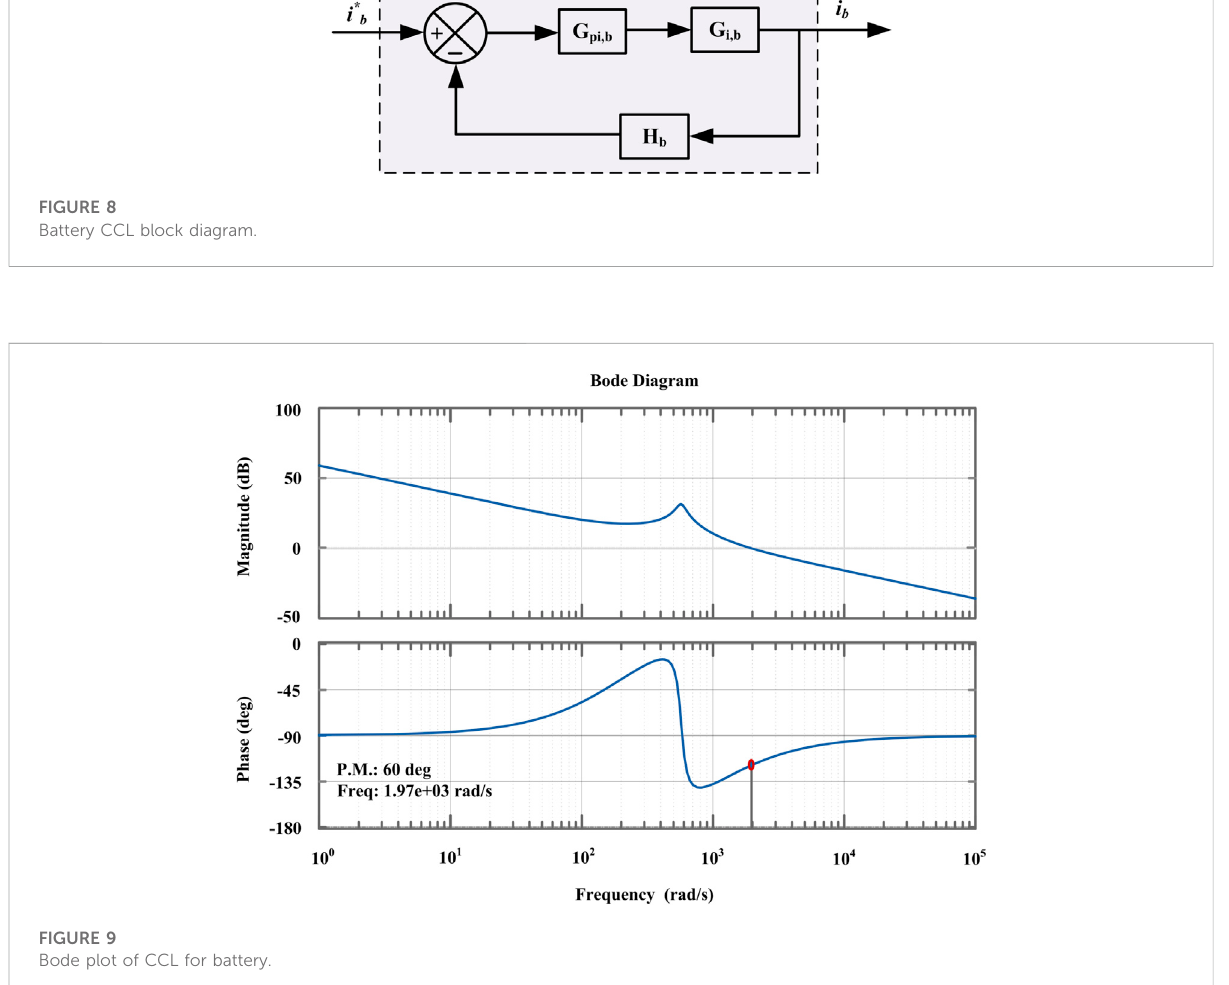
FIGURE 9 Bode plot of CCL for